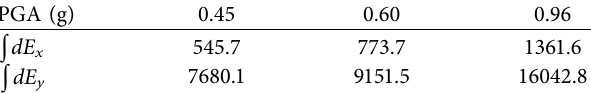
Table 10: Energy consumption of the pier in x and y directions.